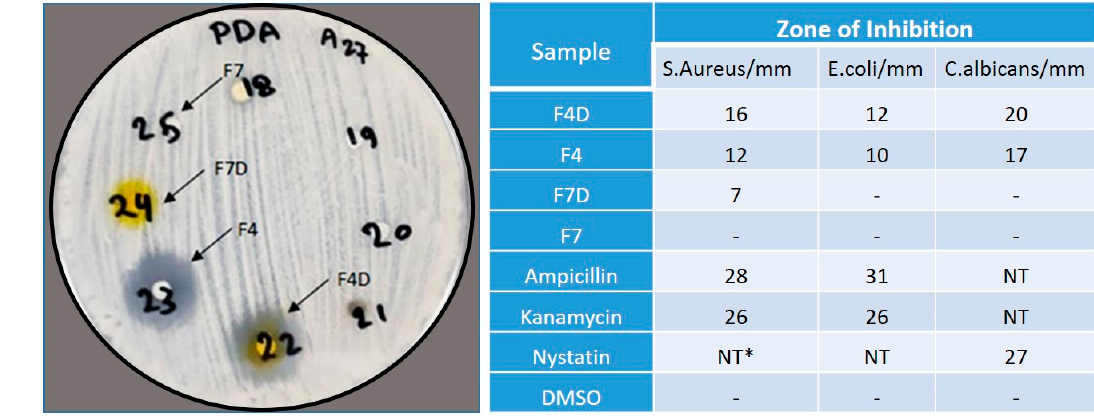
Figure 9. Antimicrobial activities of the representative F4-(BSO / I988 / KolliphorEL (35 / 15 / 50 %w / w )) and F7-(HCO-30), with and without CUR, against Staph. aureus , E. coli, and C. albicans. F4 and F7 denote the blank formulations, and F4D and F7D the drug-loaded formulations, respectively. NT*, not tested.